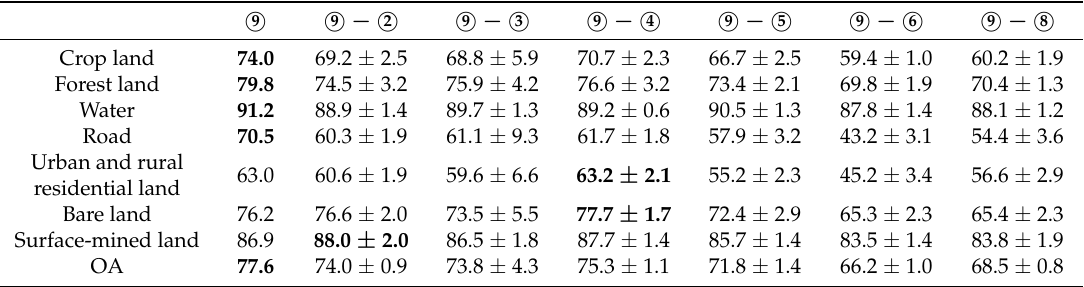
Table 9. The F1-measure and overall accuracy (OA) (%) for land cover classification in surface-mined landscapes that involved the exclusion of different types of feature sets from feature subset ( 9 (cid:13) ): 1 (cid:13) : spectral bands; 2 (cid:13) : vegetation index; 3 (cid:13) : PC bands; 4 (cid:13) : the Gaussian low-pass filters; 5 (cid:13) : the mean filters; 6 (cid:13) : the standard deviation filters; and 8 (cid:13) : topographic variables. The sign “ − ” represents exclusion of certain feature sets from the feature subset. The bold values represent the best F1-measures and OA values. The accuracies with standard deviation were averaged on 10